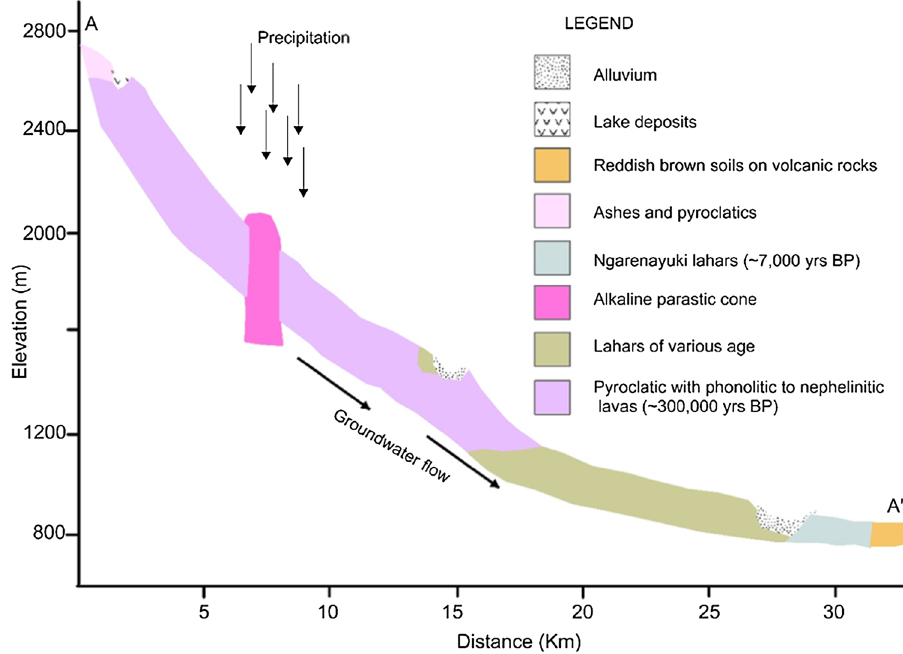
Fig. 3 Cross section from Mt. Meru to low land area as derived from the traverse A–A ′ in Fig.